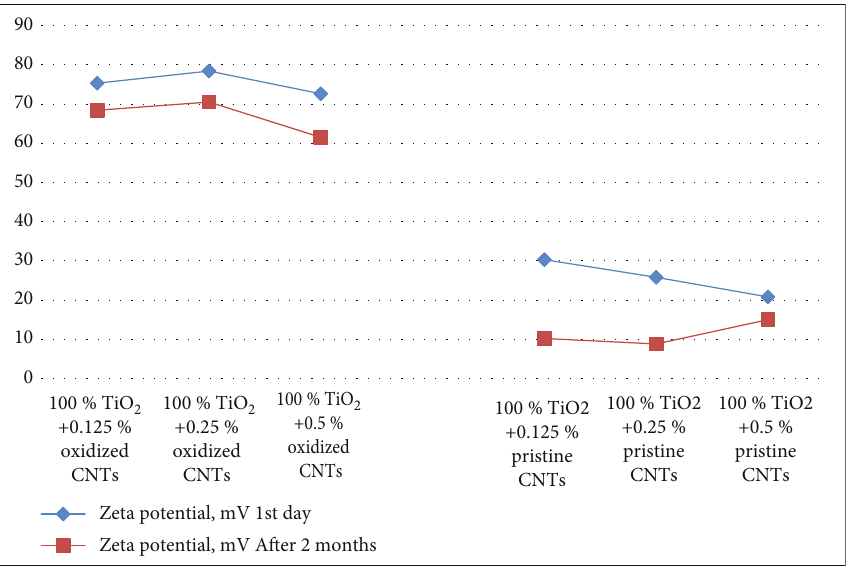
Figure 10: Zeta potential changes of nano fl uids including pristine and oxidized CNTs during 60 days for a 100 percent TiO combination.